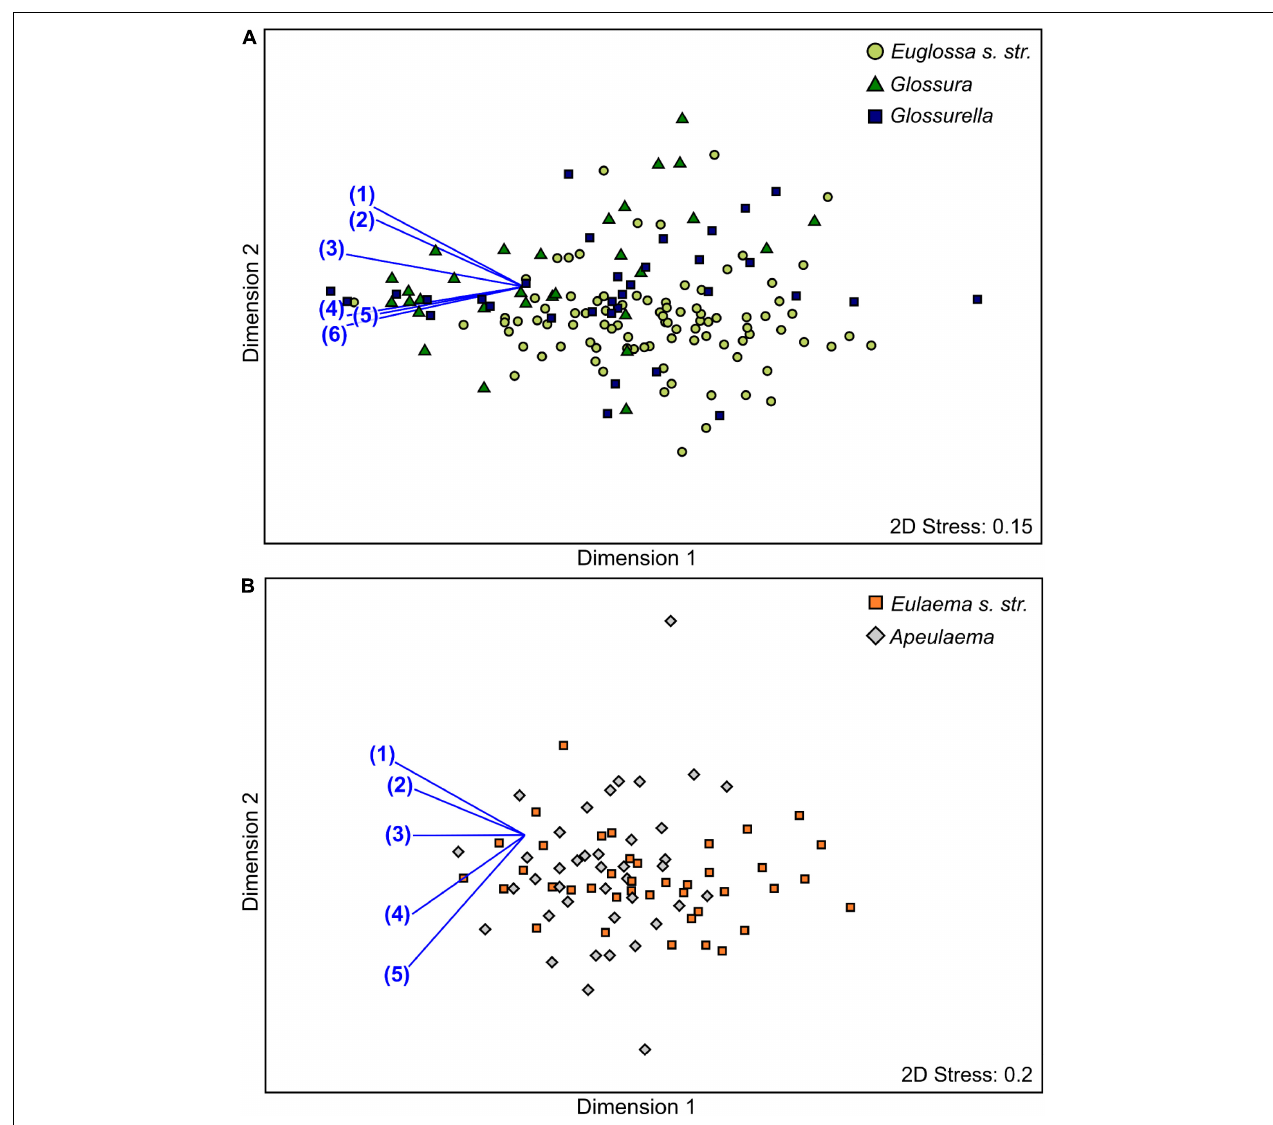
FIGURE 3 | Non-metric multidimensional scaling (nMDS) representation of antennal responses of different euglossine genera to 23 compounds, based on a Bray Curtis similarity matrix (standardized responses in percent). The single dots represent single bee individuals. Vectors represent the Pearson correlations for compounds most responsible for the dissimilarity in antennal response profiles between genera as indicated in a SIMPER analysis. (A) Subgenera within Euglossa (i.e., Euglossa s. str ., Glossurella, and Glossura ); (1) α -humulene, (2) α -copaene, (3) terpinen-4-ol, (4) α -pinene, (5) ( − )-( E )-carvone epoxide, (6) ipsdienol. (B) Subgenera within Eulaema (i.e., Eulaema s. str. and Apeulaema ); (1) α -phellandrene, (2) eugenol, (3) ipsdienol, (4) eucalyptol, (5) ( − )-( E )-carvone